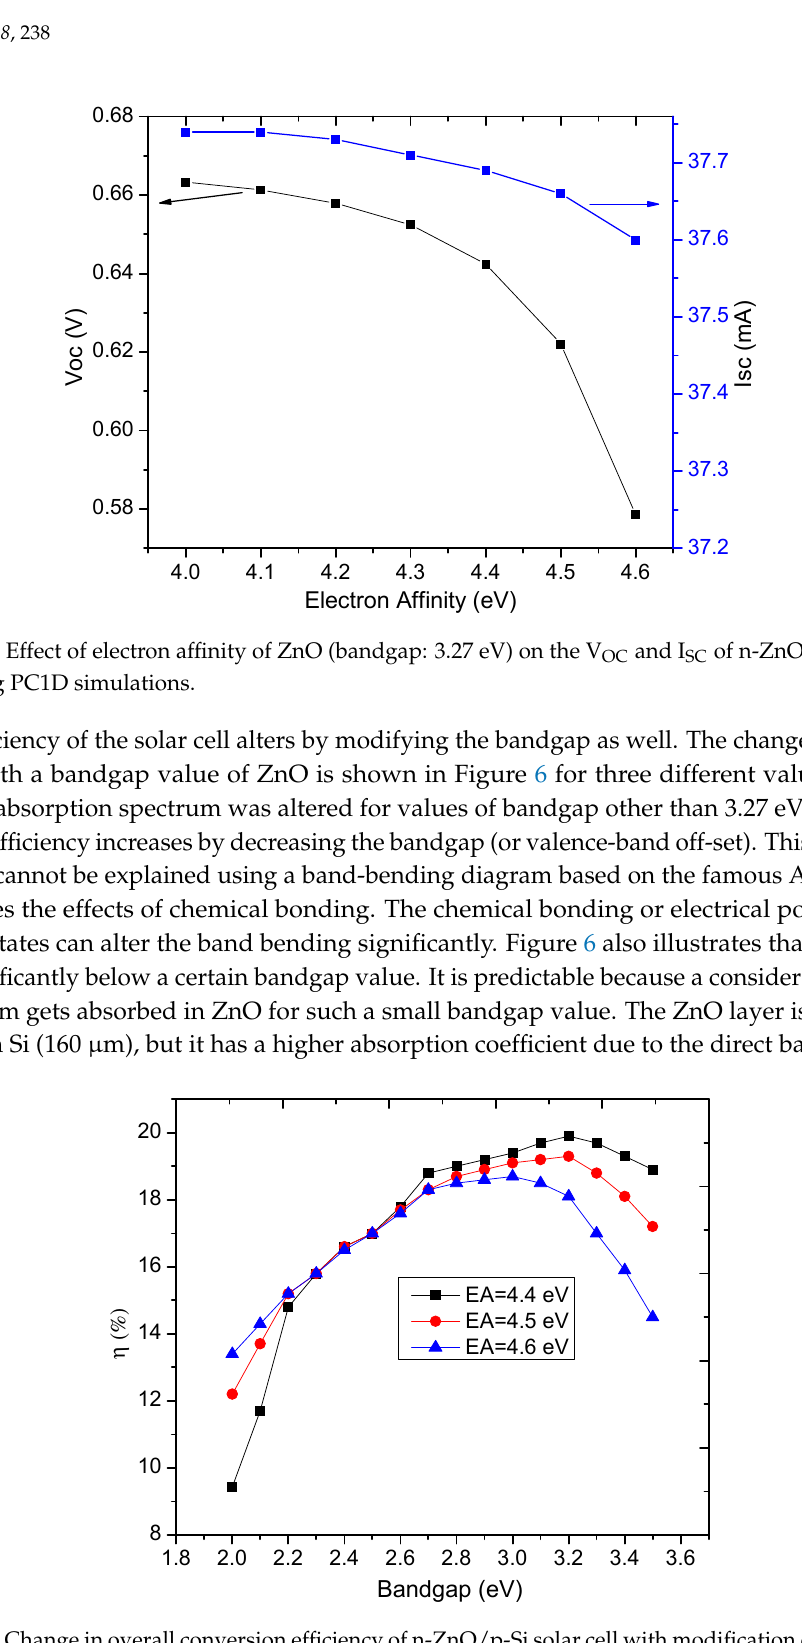
Figure 6. Change in overall conversion efficiency of n-ZnO/p-Si solar cell with modification of bandgap value of ZnO for three different values of electron affinity (EA). Few data points have been interpolated because numerical solution was not converging for those points in PC1D.